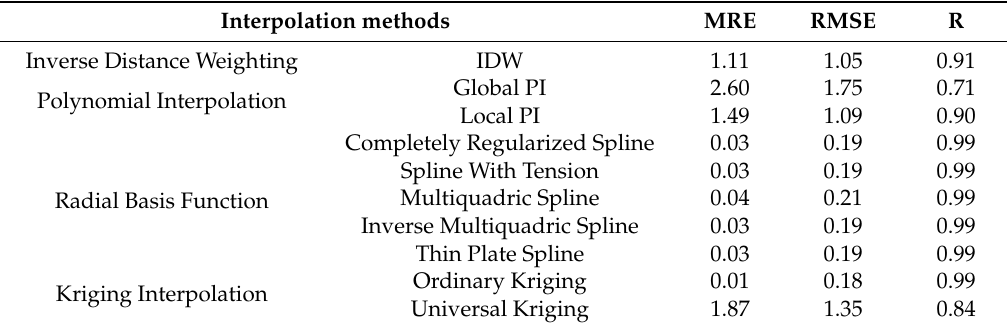
Table 3. Comparison of different interpolation